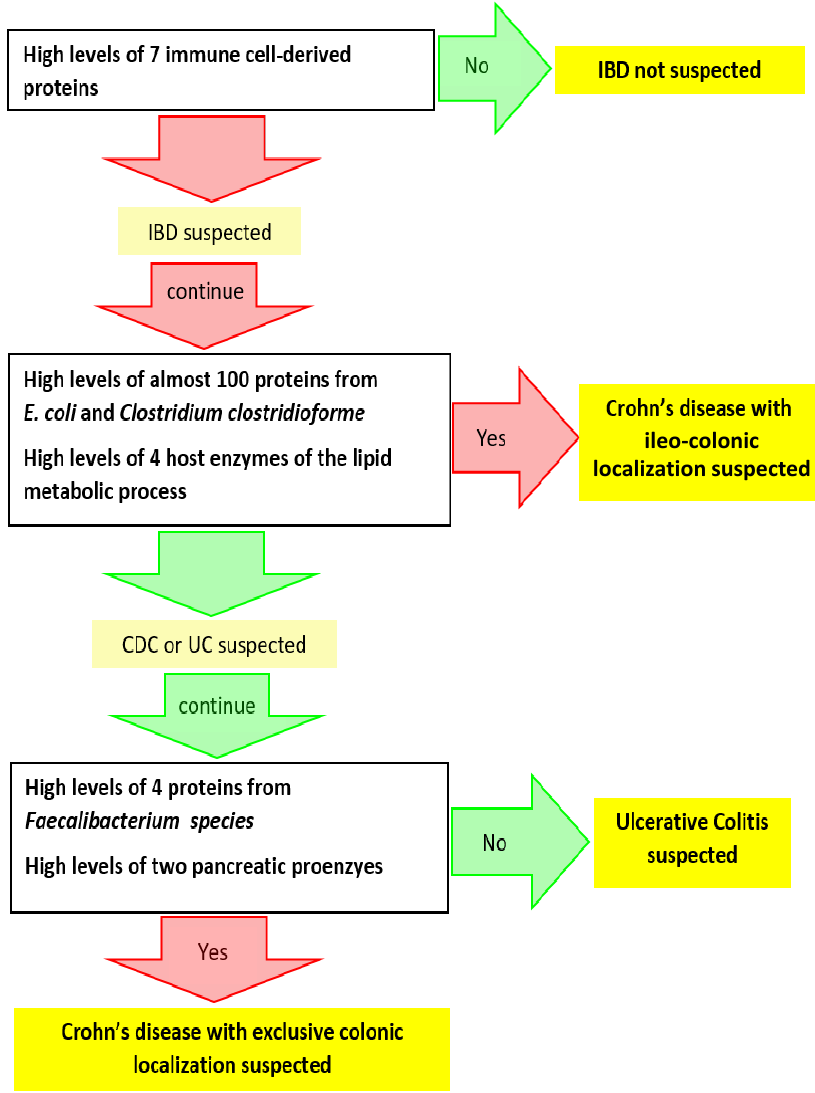
Figure 5. Leads for further trials aimed at consolidating a decision tree based on modern gut metaproteomics: a potential additional tool to supplement clinical grounds, medical imagery, and histology in the early diagnosis of IBDs.